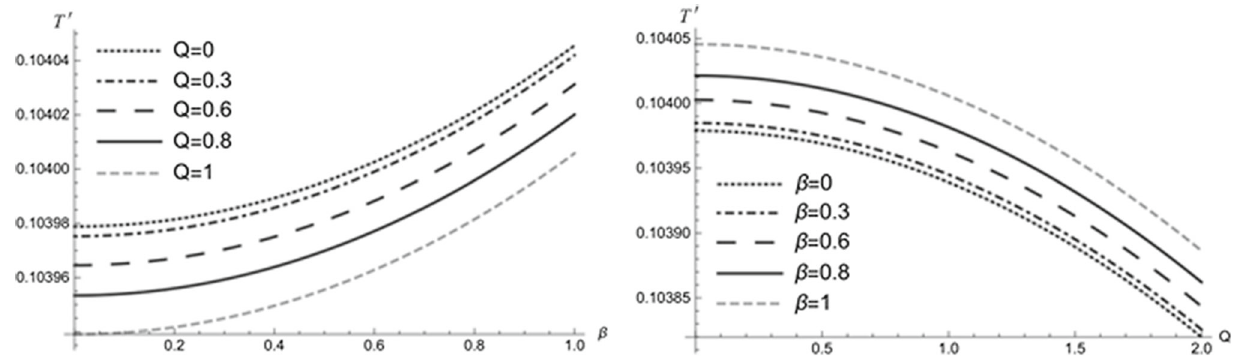
Fig. 3 The left panel: the GUP-corrected temperature vs. β . The right panel: the GUP-corrected temperature vs. Q . In both cases we take ¯ h = 1 , P = 0 . 01 , r 0 = 10